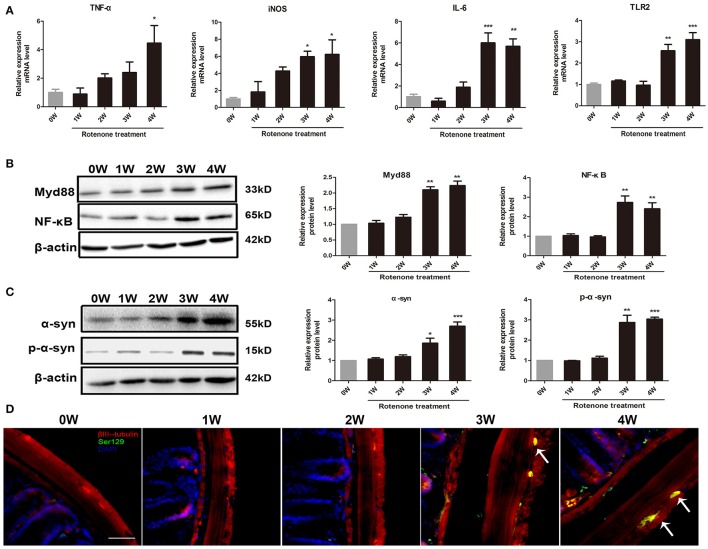
Progressive increase in inflammation and α-synuclein pathology in the colon of rotenone-treated mice. (A) Inflammatory cytokines (TNF-α, iNOS, IL-6) and TLR2 mRNA level in colon as determined by real-time RT-PCR. (B) Representative blots of Myd88 and NF-κB in colon from rotenone-treated mice. (C) Representative blots of α-syn and Ser129 α-syn (p-α-syn) in colon from rotenone-treated mice. (D) Representative photomicrographs of colon sections immunostained for anti-βIII-tubulin, anti phospho-α-synuclein (Ser 129), and DAPI staining in rotenone-treated mice (the presence of phospho-α-synuclein staining was shown by the arrows). Scale bar = 50 μm. Data are expressed as means ± SEM of at least 3 mice, *p < 0.05, **p < 0.01, ***p < 0.001 vs. 0W.